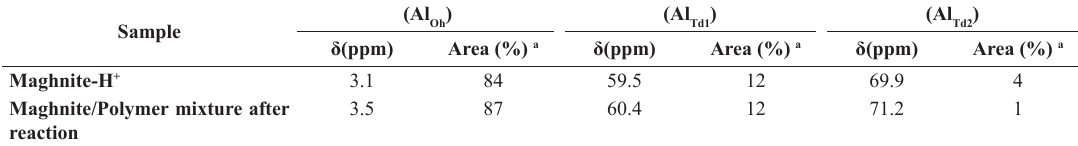
Table 3. 27 Al NMR Chemical Shifts and Signal Area (%) in Maghnite-H + and Maghnite/Polymer mixture after reaction Sample